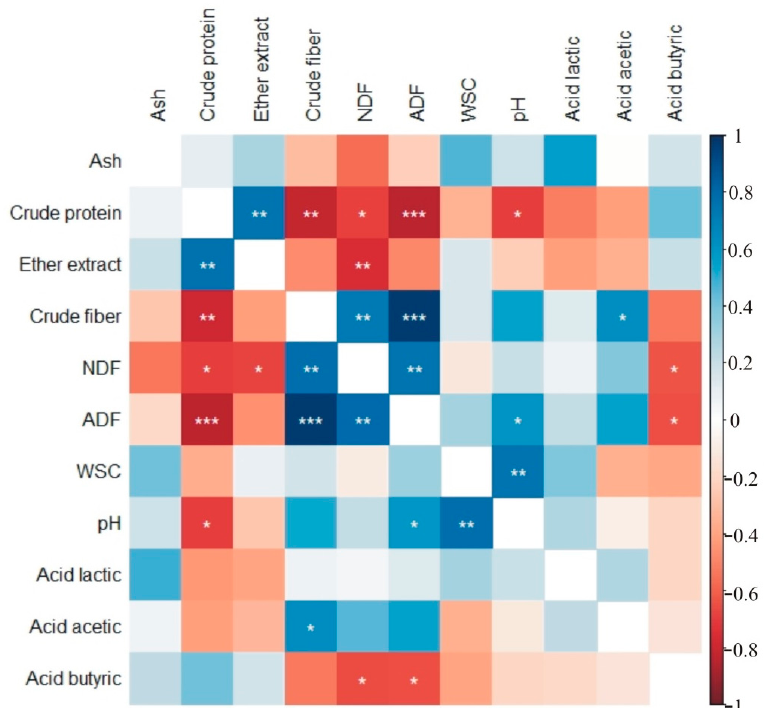
Figure 2. Heatmaps of correlation coefficients for traits of control silage (above diagonal) and of silage treated with amino acids (below diagonal), r cr = 0.576. (NDF—neutral detergent fiber, ADF—acidic